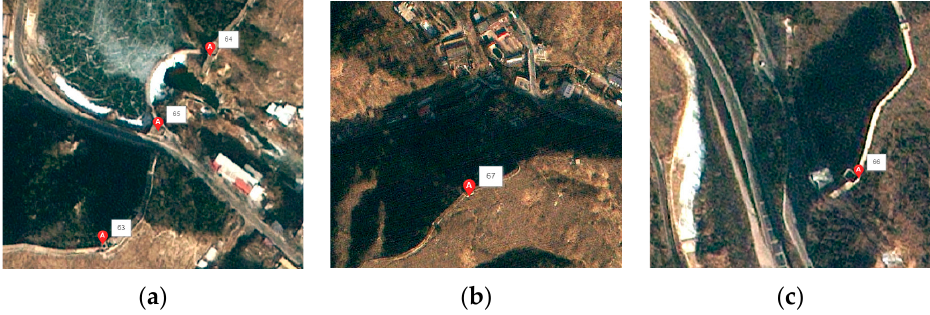
Figure 1. Deployment of the monitoring systems: ( a ) Erdaoguan Great Wall; ( b ) Qiliankou Great Wall; and ( c ) Hefangkou Great Wall.